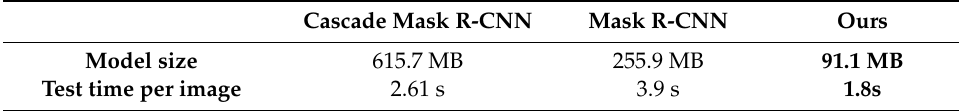
Table 5. Comparison of detection speed and model size.